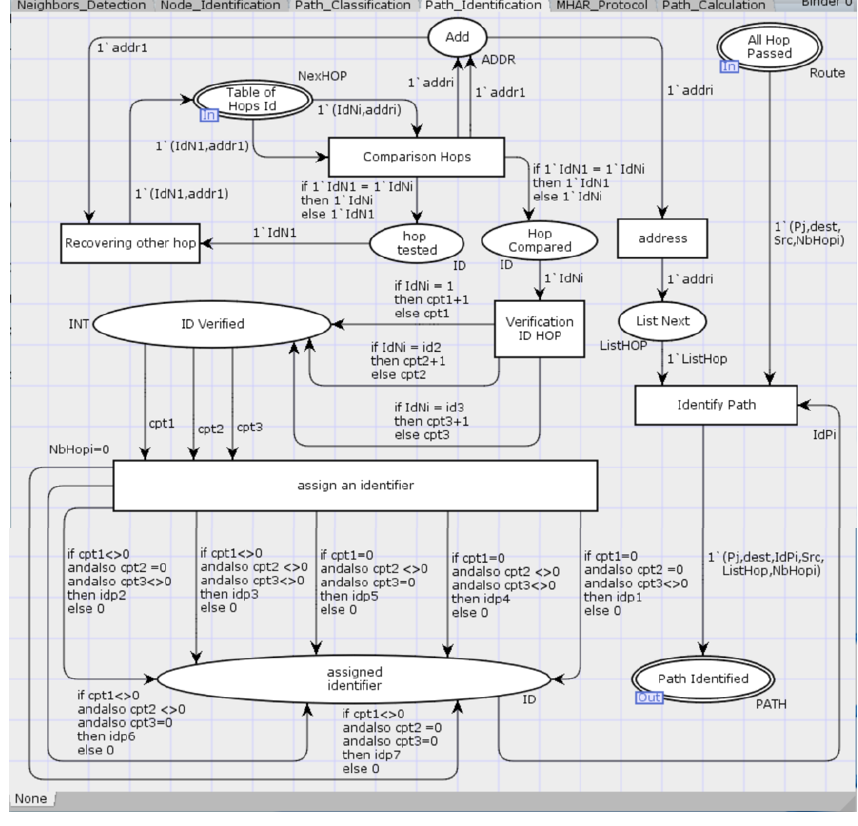
Figure 6. Path identification module.